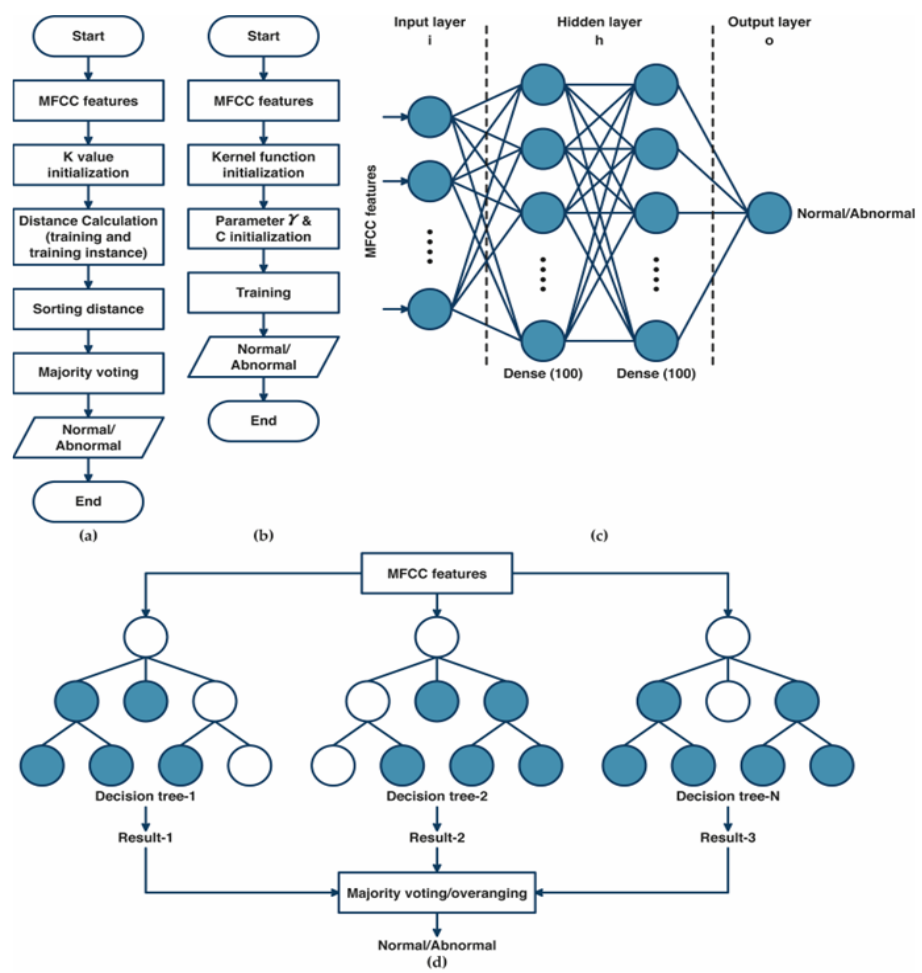
Figure 3. ( a ) The diagram of the k-nearest neighbor classifier algorithm; ( b ) The diagram of the support vector machine classifier algorithm; ( c ) The architecture of the artificial neural network algorithm; ( d ) The topology of random forest classifier algorithm.